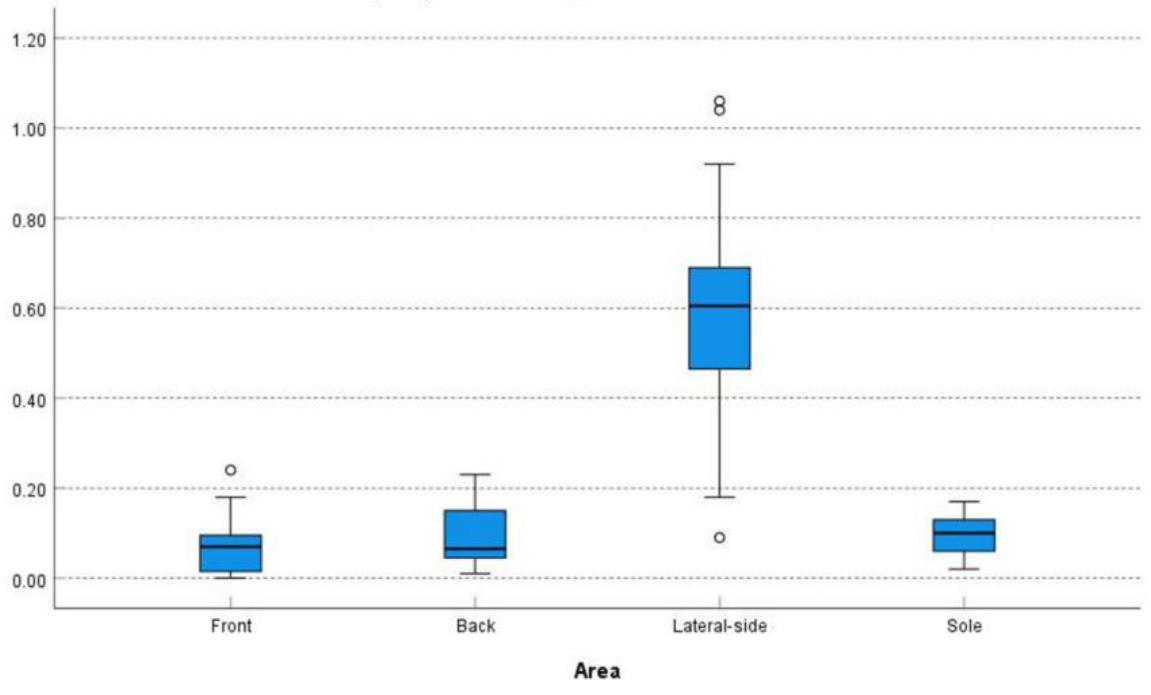
Figure 3. Diagram of the absolute values of difference between both sides (|ΔT|, |right— left|) in each of the four areas. ROIs: region of interests; and ◦ are labels that are out of range.